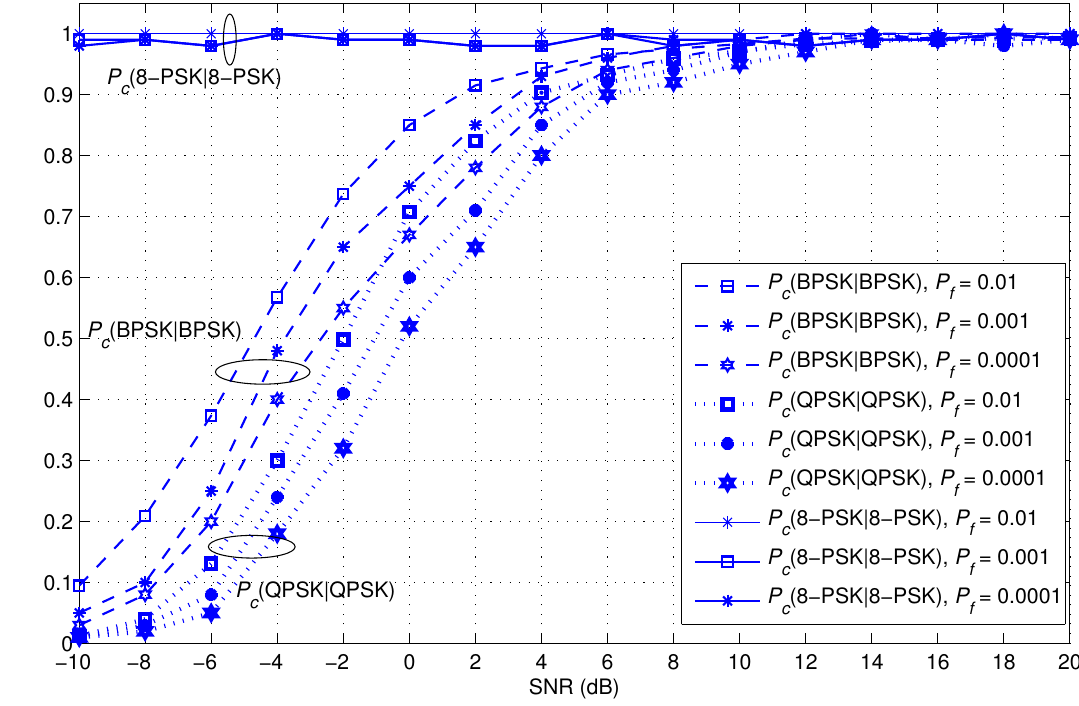
Figure 13. The effect of P f on the categorization performance for the modulation set of Ω 2